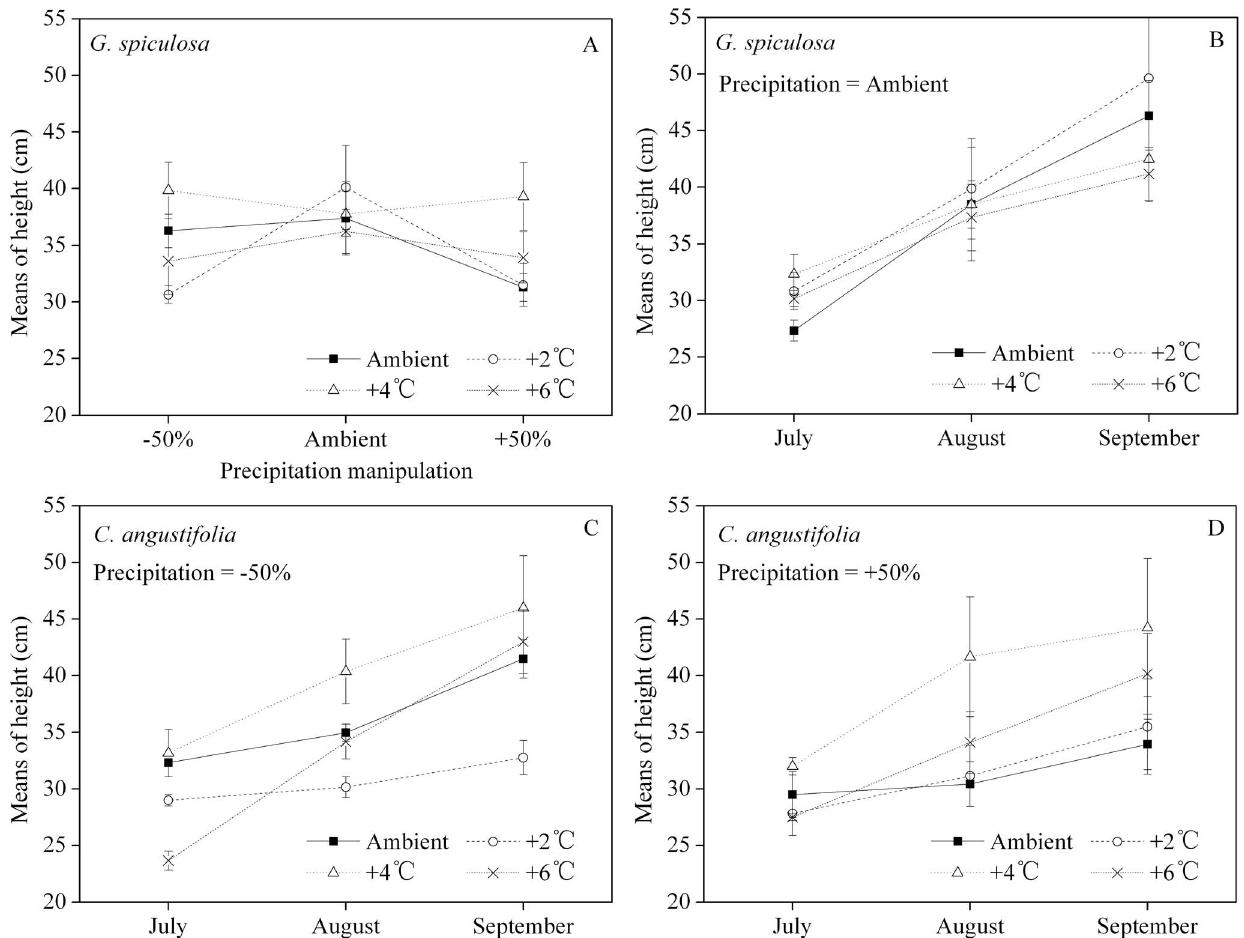
Figure 2. Interaction of temperature and precipitation manipulations on plant height (A) of Glyceriaspiculosa , and the monthly estimated marginal means of height of G.spiculosa for different temperature treatments when the precipitation was manipulated at ambient (B), 2 50% (C) and + 50% (D) levels, respectively. The error bars represent means 6 1 standard error.